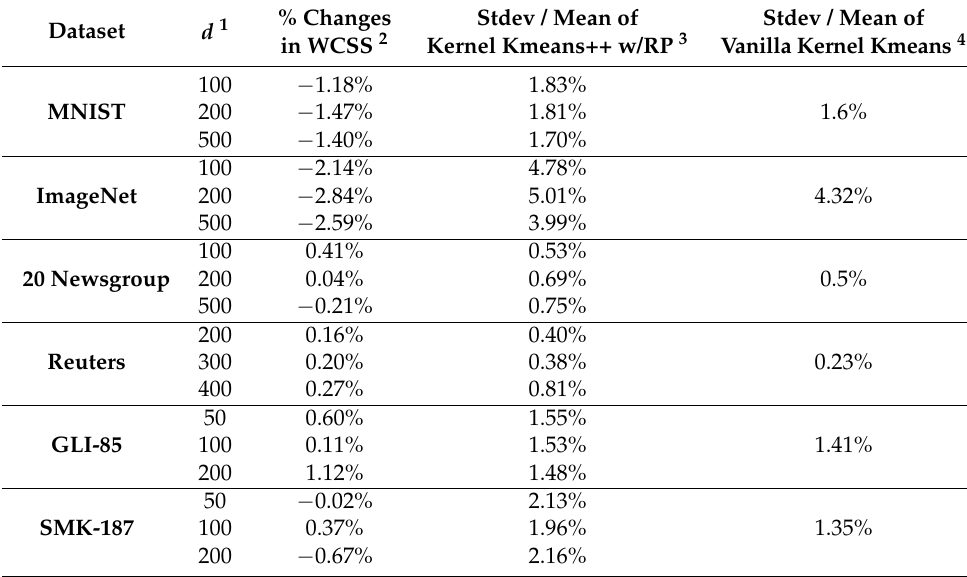
Table 4. Other clustering accuracy measurements of our